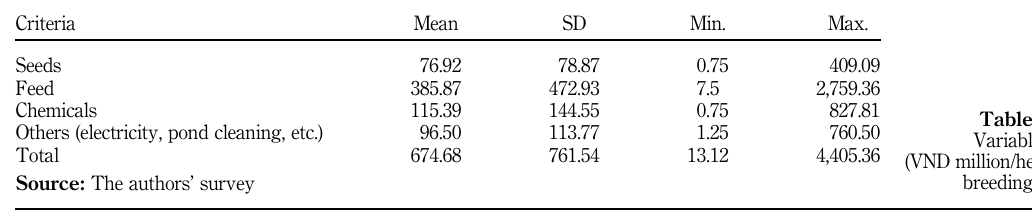
Table VIII. Variable